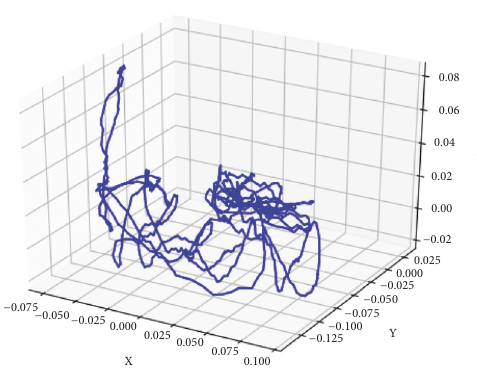
Figure 11: The estimated trajectory of the real scene sequence; the unit in the figure is